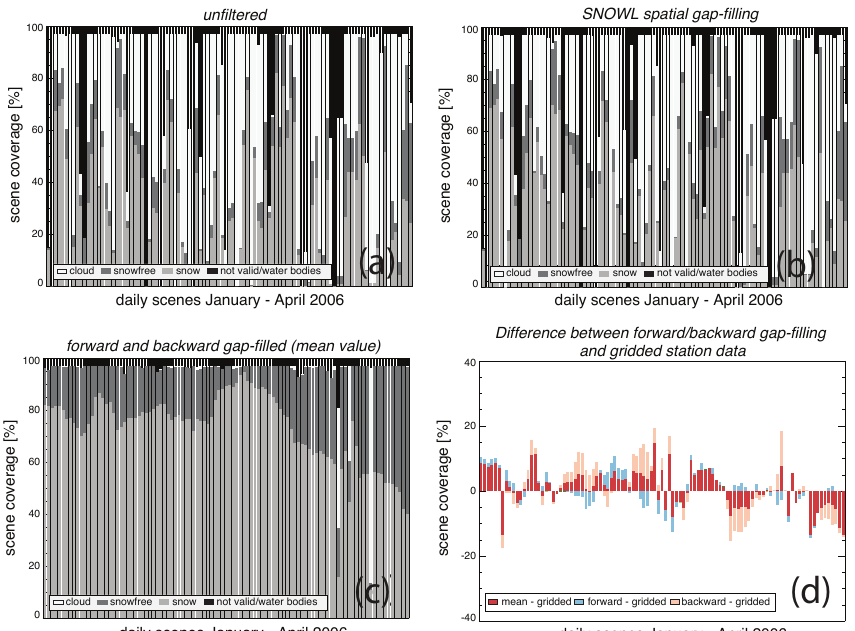
Fig. 3. Stepwise results from the spatial and temporal cloud removal process for the period January–April 2006: respective area percentage of Switzerland for the classes snow, snow free, cloud and not valid for (a) unfiltered scenes, (b) after SNOWL spatial gap-filling filter, (c) after temporal backward and forward gap-filling (mean value), (d) differences between forward and backward direction and averaged value thereof (calculated as the mean between the SCA value from the forward gap-filled product and the SCA value from the backward gap-filled product for the same day) and gridded station data.